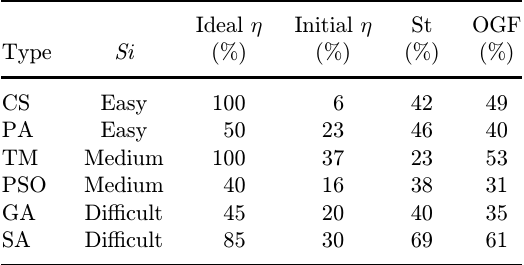
Table 1. Comparison of six optimization algorithms for wavefront